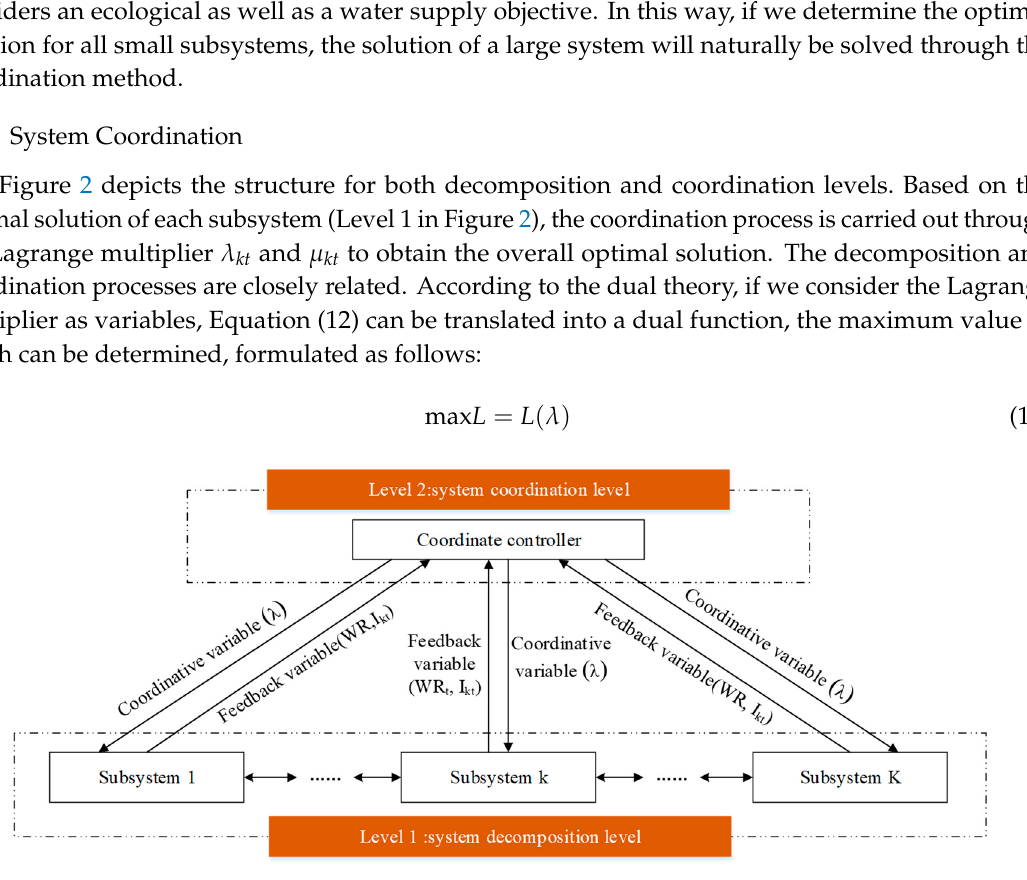
Figure 2. Structure of the large system based on the decomposition and coordination method.